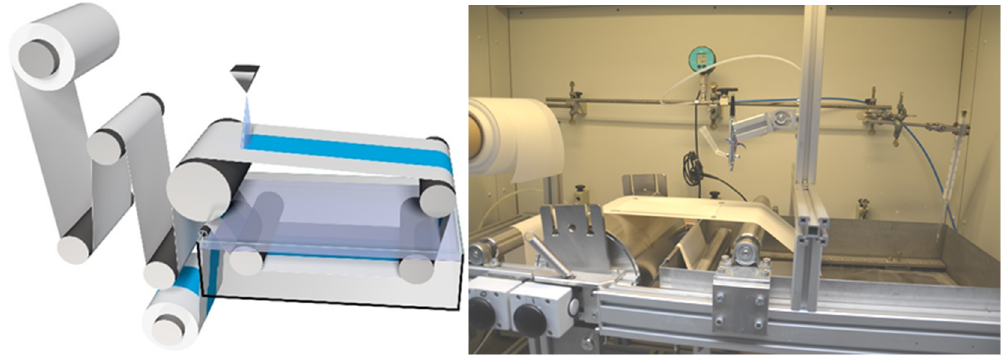
Figure 2. Schematic view of the in-house casting machine for lab-scaled membrane casting ( left ) and image ( right ).